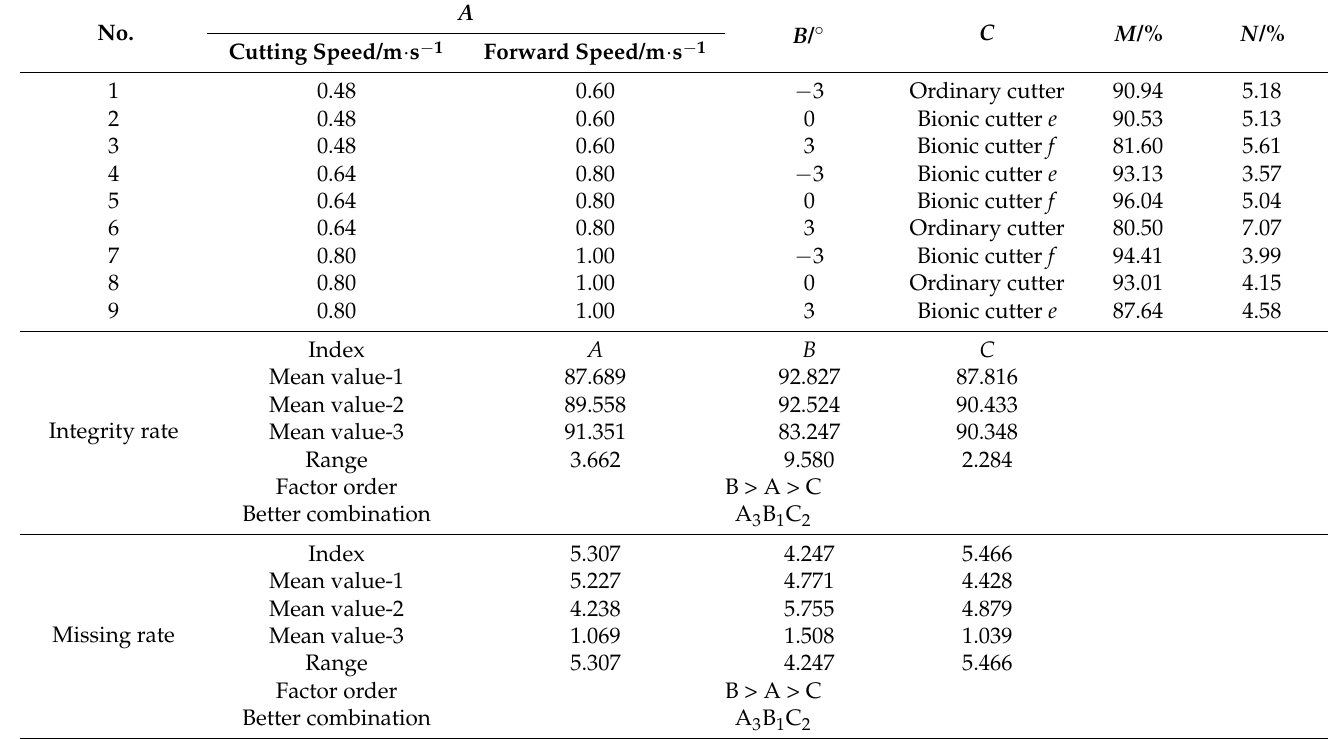
Table 6. Orthogonal test results of field cutting performance.